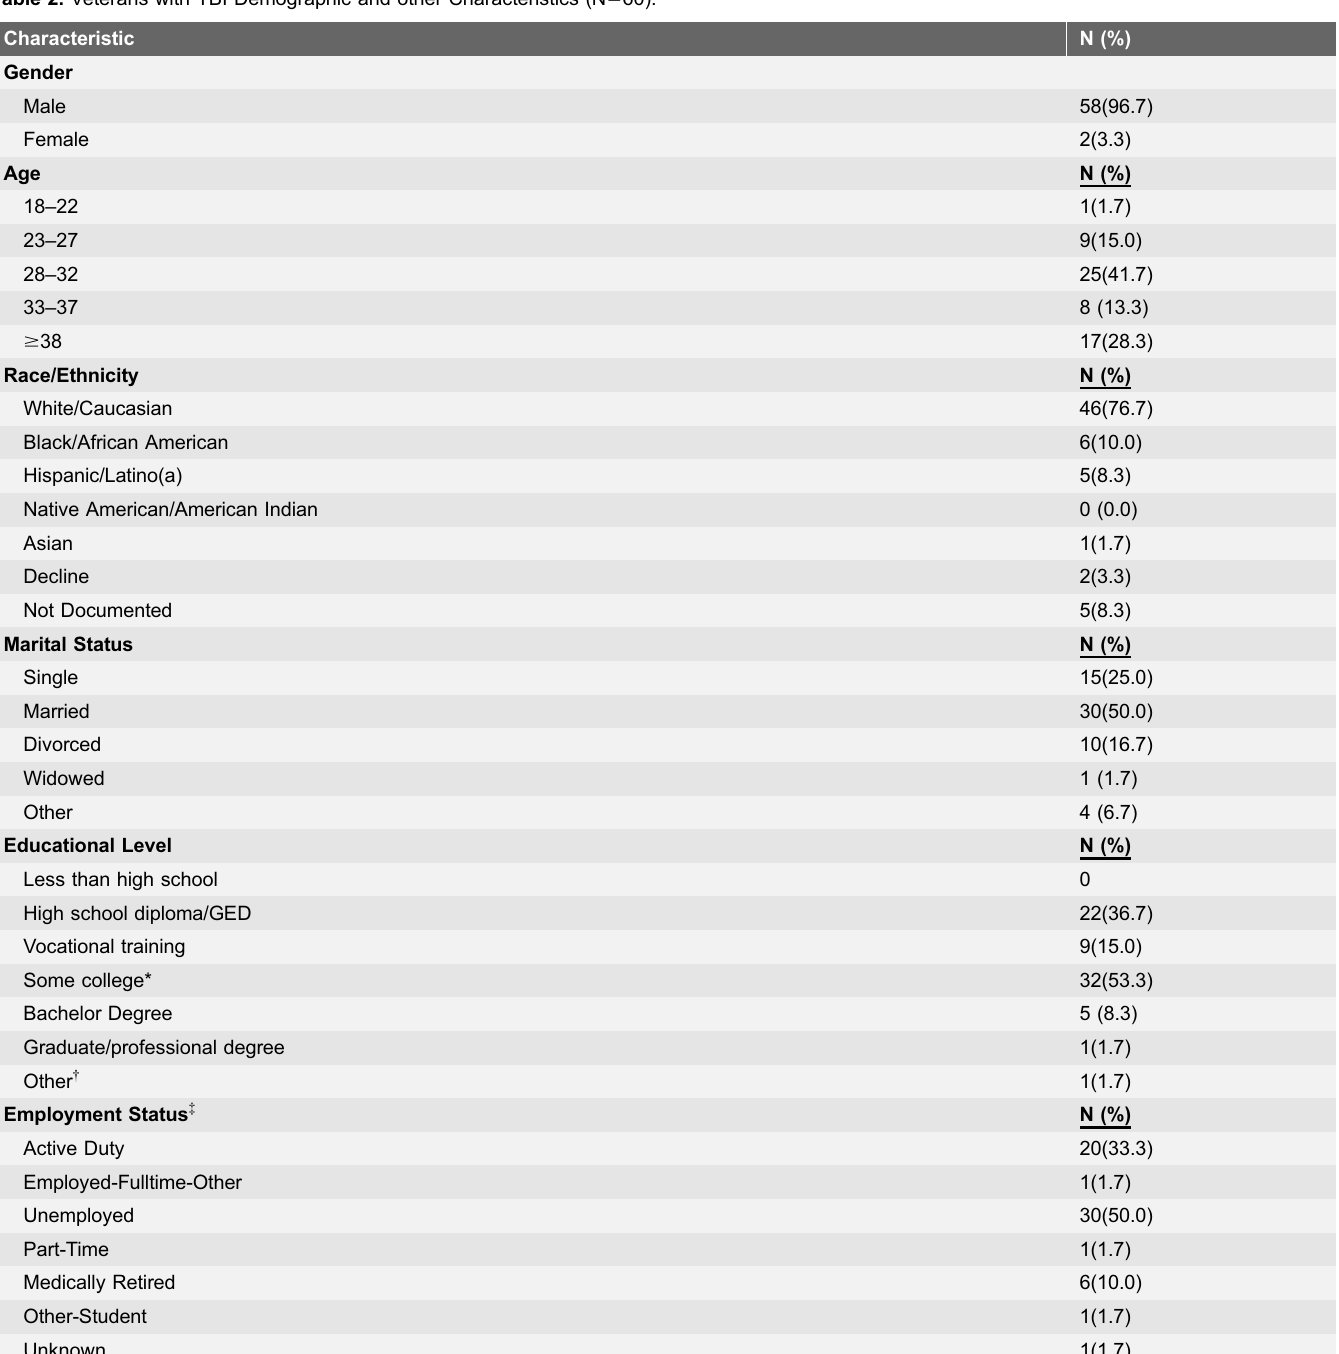
Table 2. Veterans with TBI Demographic and other Characteristics (N 5